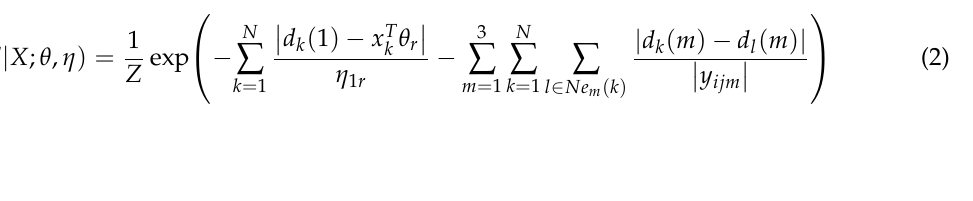
( b ) Figure 3. The extracted depth maps: ( a ) the person in the image is about 5 m away from the camera and ( b ) the person in the image is about 2 m away from the camera. 2.2. Particle Swarm Optimization-Based Human Detection and Initialization for Tracking 2.2.1. Particle Swarm Optimization The particle swarm optimization (PSO) method was designed for observing and simulating collective behaviors, such as those of a flock of birds or school of fish [35]. For every iteration, PSO allows the particles to progressively seek the optimal value. In other words, for each iteration we calculate the fitness value for a group of variables in each of the particles and move towards the nearest optimal value and continue this tightening pattern to progressively bring the particles closer to the optimal value.